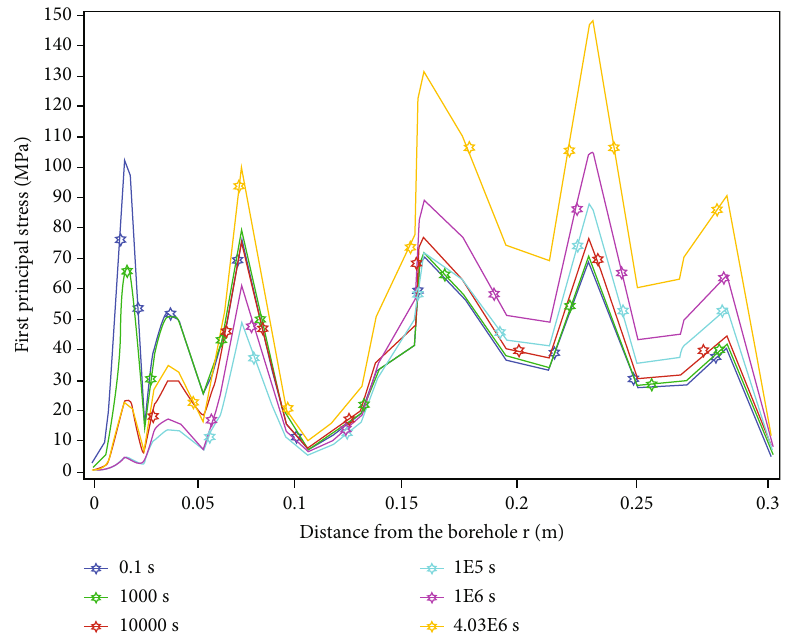
Figure 25: First principal stress in the m = 1 coal rock during CBM production.